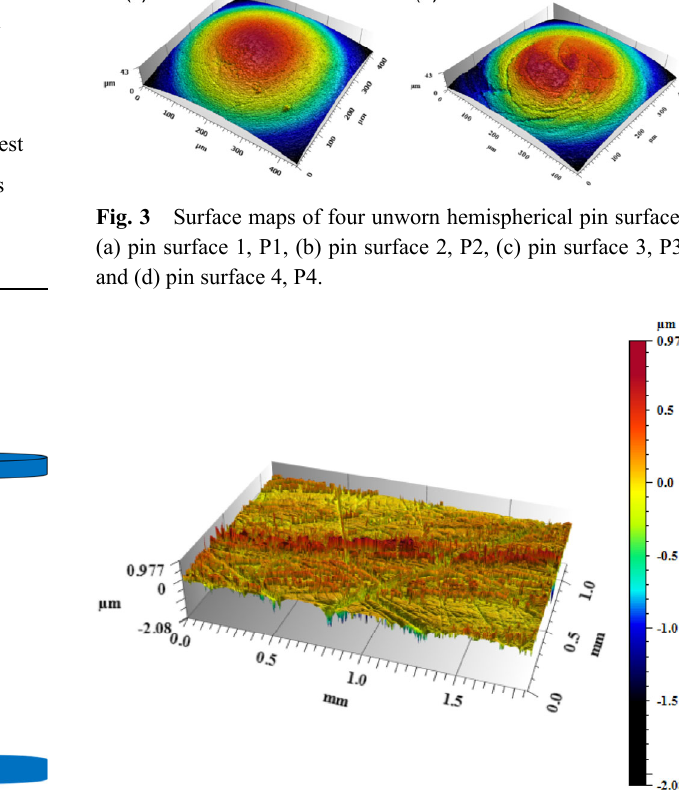
Fig. 2 Schematic of overall test procedure.